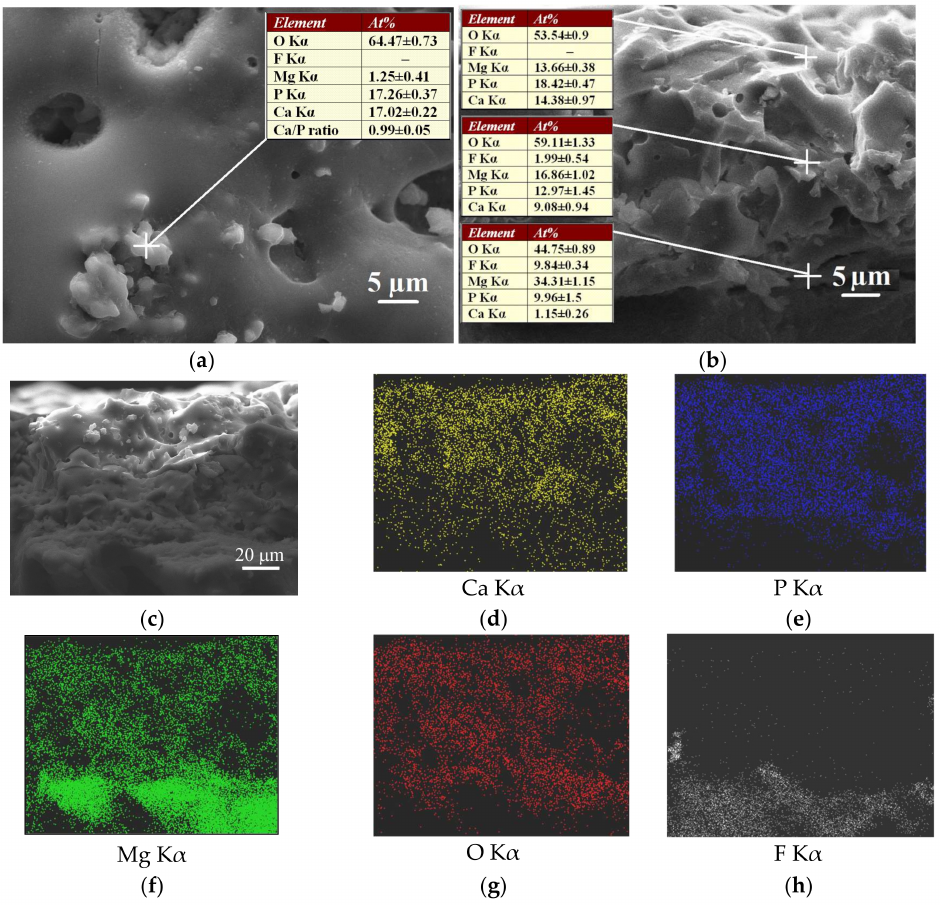
Figure 7. SEM micrographs of the top surface ( a ) and cross-sectional CaP coatings ( b , c ) deposited at 450 V for 5 min and energy-dispersive X-ray spectroscopy (EDX) mapping of the elemental distribution within the coatings ( d – h